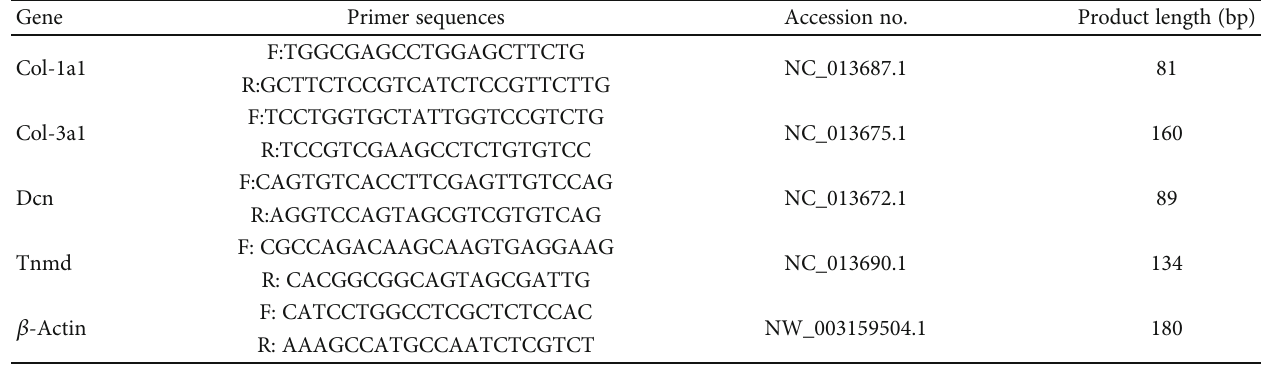
Table 1: Primers used in qRT-PCR.